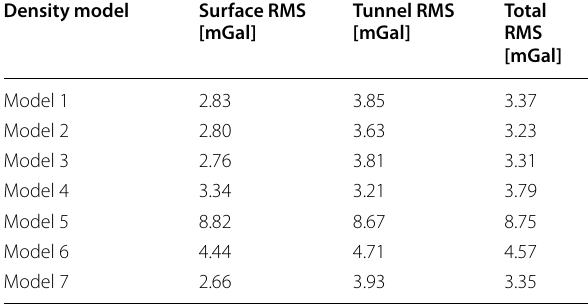
Table 3 Root-mean-square misfit obtained by comparing synthetic forward modelling results and corrected gravity observations, for both surface and tunnel data, for various density